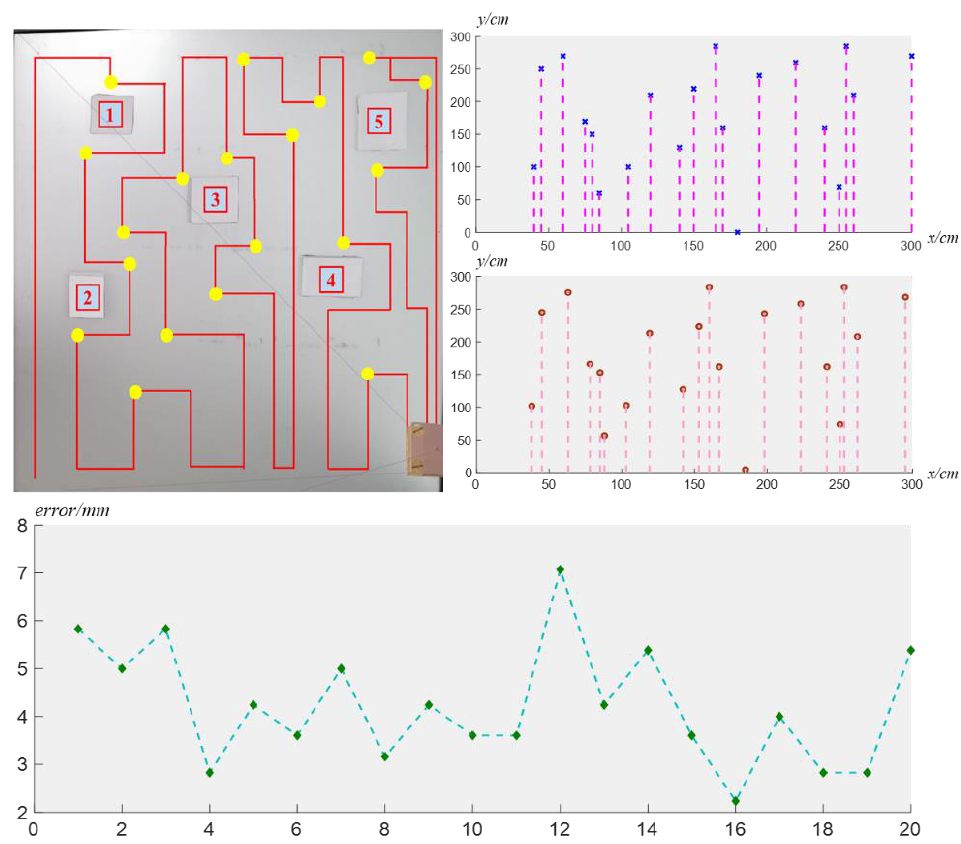
Figure 15. Body position errors.